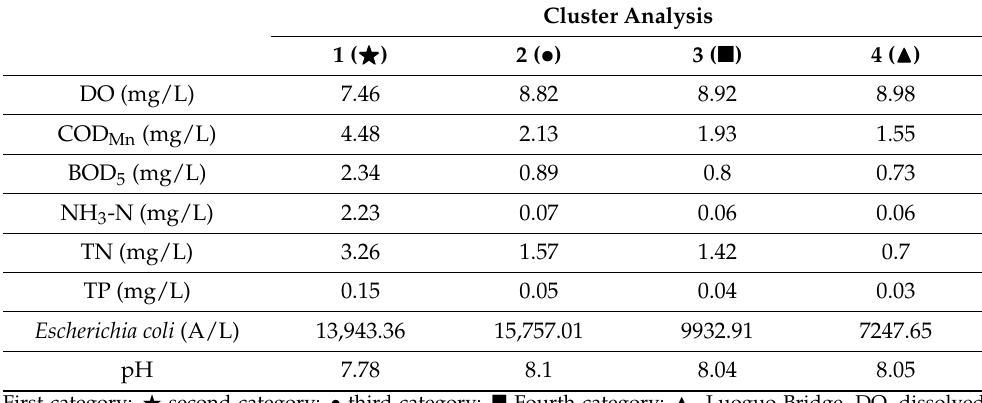
Table 4. Water quality clustering and monitoring indicators in the Wudongde Reservoir from 2016 to